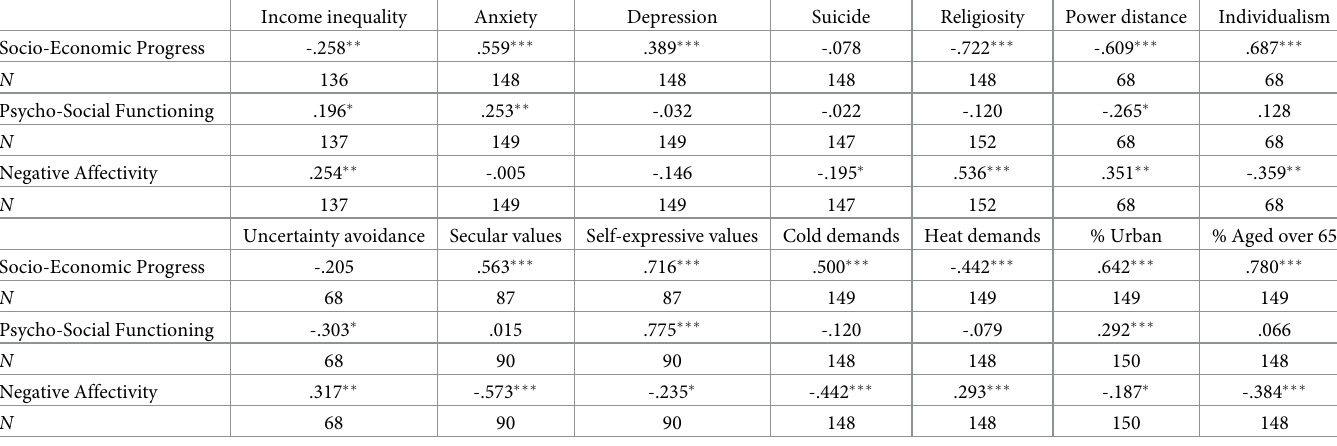
Table 7. Correlations between the well-being dimensions and external